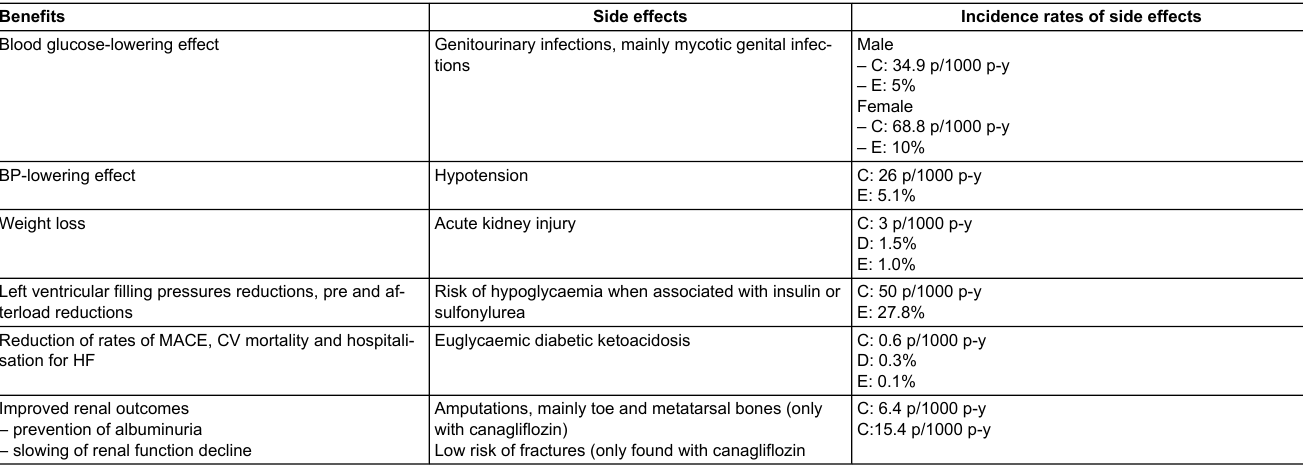
CV = cardiovascular, HF = heart failure; MACE = major adverse cardiovascular events, defined as the composite of cardiovascular death, non-fatal myocardial infarction and non- fatal stroke; PAD = peripheral arterial disease; p/P-y = patients/1000 patient-years Incidence rates of side effects are based on the CANVAS-Program [2], DECLARE-TIMI 58 [3] and EMPAREG-OUTCOME [1] trials. They are expressed as number of patients for 1000 patient-years for canagliflozin (C), as percentages for dapagliflozin (D) and empagliflozin